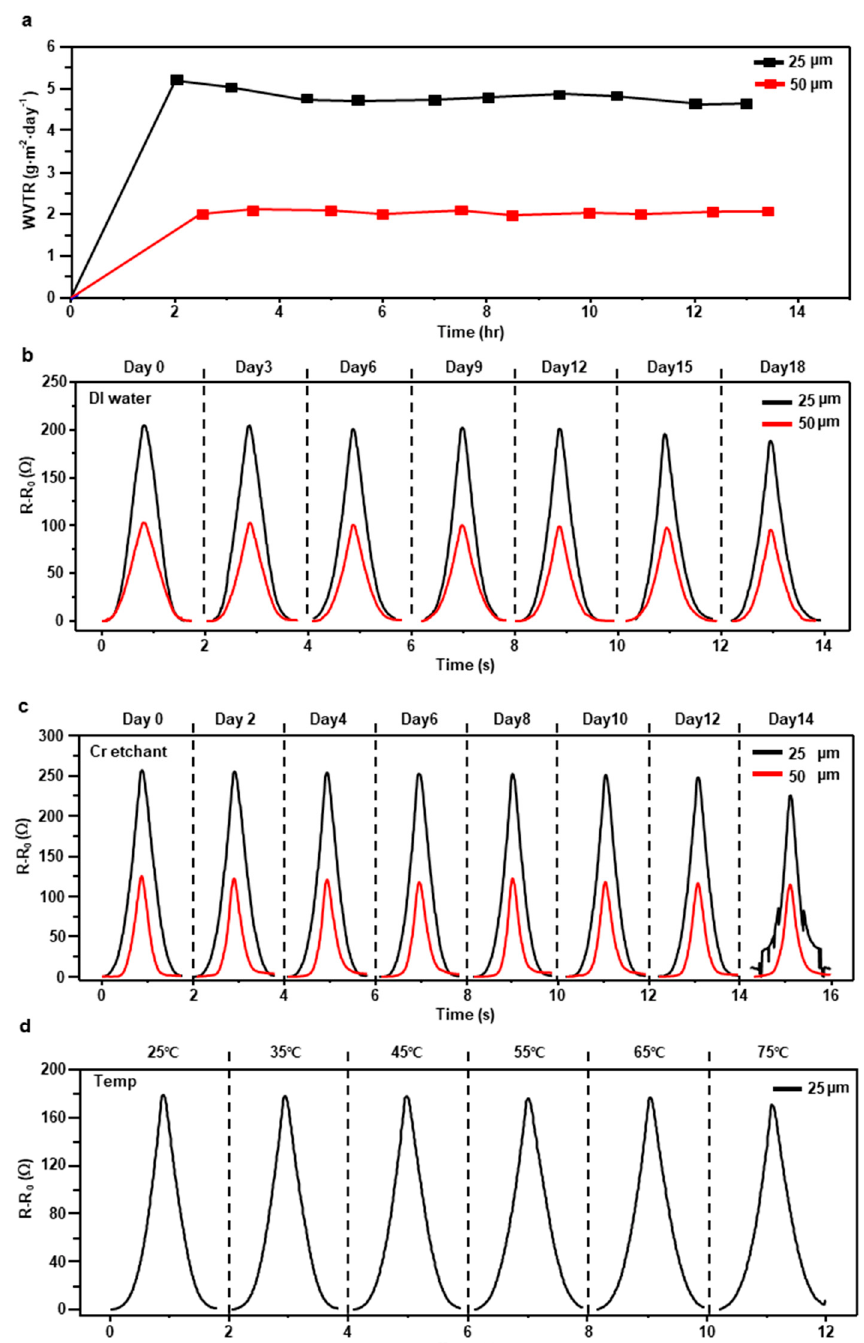
Figure 3. ( a ) Water vapor transmission rate (WVTR) of the 25 µm and 50 µm thick